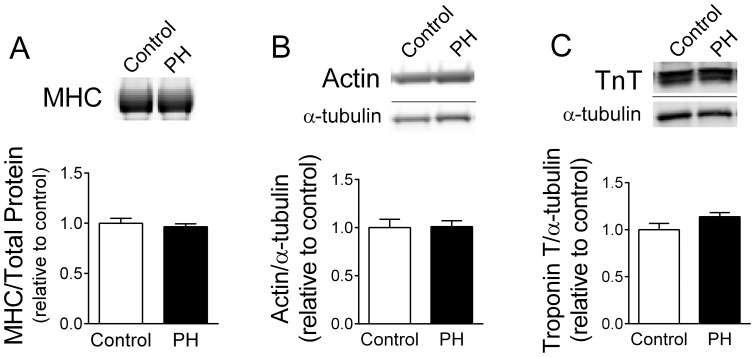
Myofibrillar protein abundance is similar in control and PH mice.
A) Images show protein bands corresponding to myosin heavy chain (∼220 kDa) in examples of control and PH mice. MHC data were normalized for total protein measured as optical density of entire lane. Molecular weights were determined from protein standards (not shown). B and C) Images are examples of lanes from membranes probed for sarcomeric actin (B) and troponin T (C) in whole-muscle homogenates. Optical density of actin and troponin T were normalized to α-tubulin in the respective membranes. All bar graphs show mean ± SE of results expressed relative to mean of control (N = 4/group).